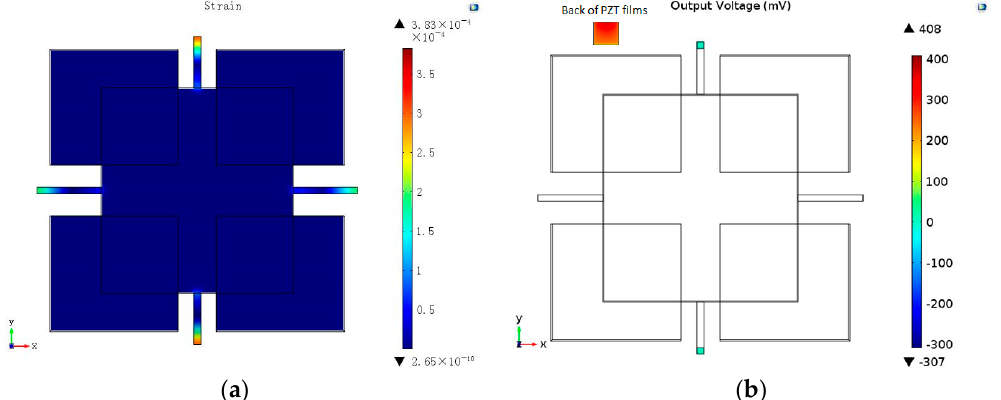
Figure 12. The distribution of maximum strain and the output voltage of the optimal structure. ( a ) The distribution of maximum strain; ( b ) The output voltage of the optimal structure. Sensors 2016 , 16 , 1587